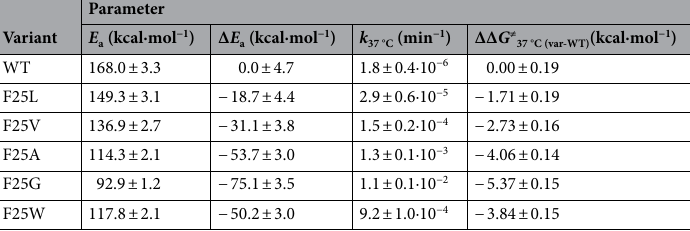
Table 1. Kinetic parameters derived from Arrhenius plots calculated from DSC data in the absence of urea. k 37 °C was obtained using 37 °C (310.15 K) as reference temperature ( T *) in Eq.